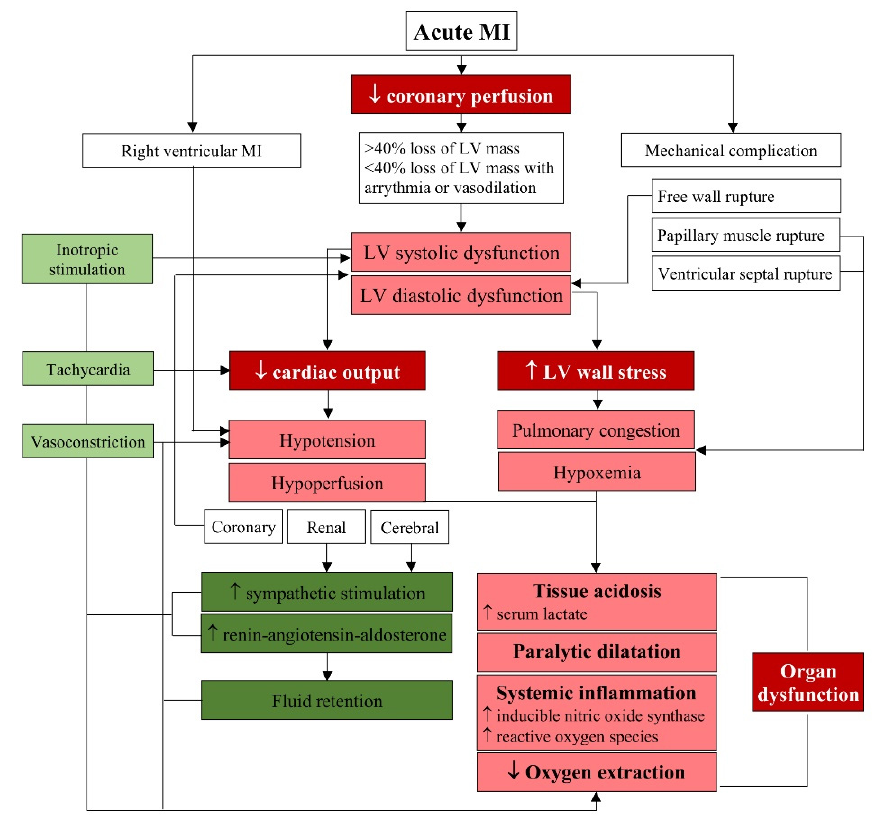
Figure 1. Pathophysiology of cardiogenic shock. The primary cause of cardiogenic shock is severe myocardial injury and cardiac dysfunction leading to a supply–demand imbalance in the peripheral end-organs. Early endogenous compensatory mechanisms are activated to prevent the irreversible consequences of hypoperfusion and hypoxemia. Abbreviations: MI myocardial infarction, LV: left ventricular.